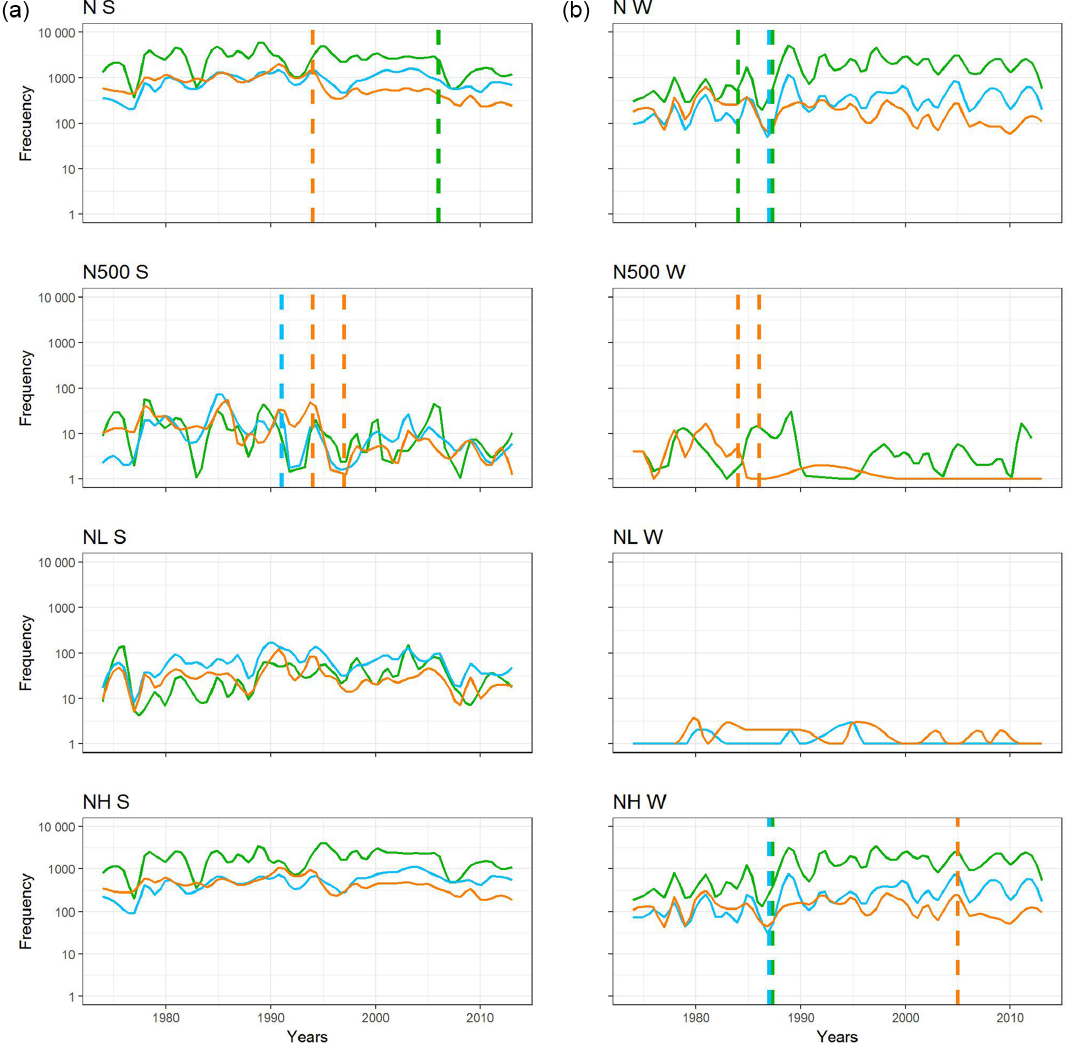
Figure 2. Detected change points and temporal evolution of fire frequency features (log scale) for the period 1974–2013 in the three regions examined: Northwest is indicated by the green line, Hinterland by the light blue line and the Mediterranean by the orange line. Column (a) refers to the summer season, while (b) is winter. Dashed vertical lines represent probable change points. See Sect. 2.1 for acronyms and description of fire